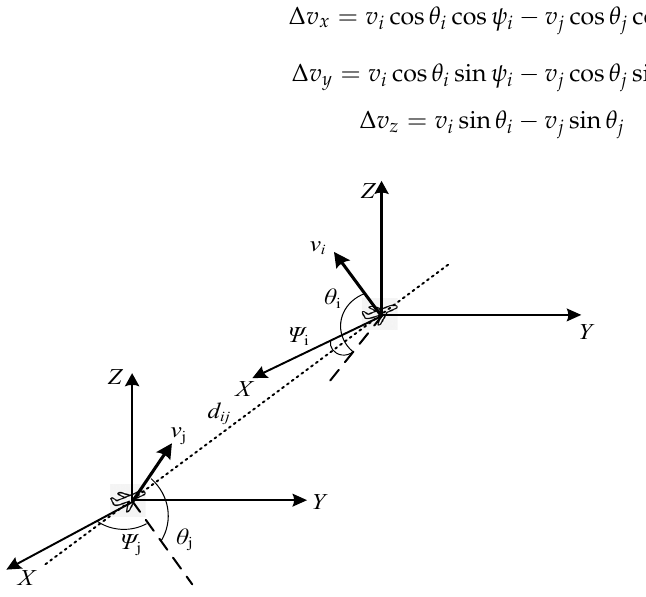
Figure 4. Relative geometric parameters of UAVs.